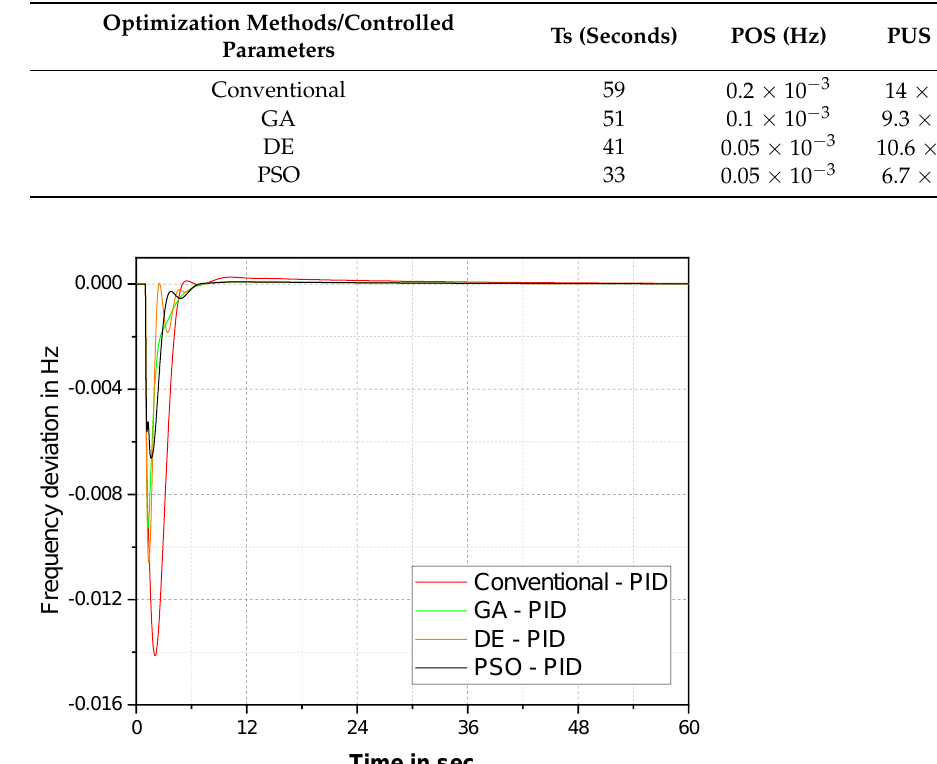
Table 7. Controlled parameters of delF using the ITAE cost function.